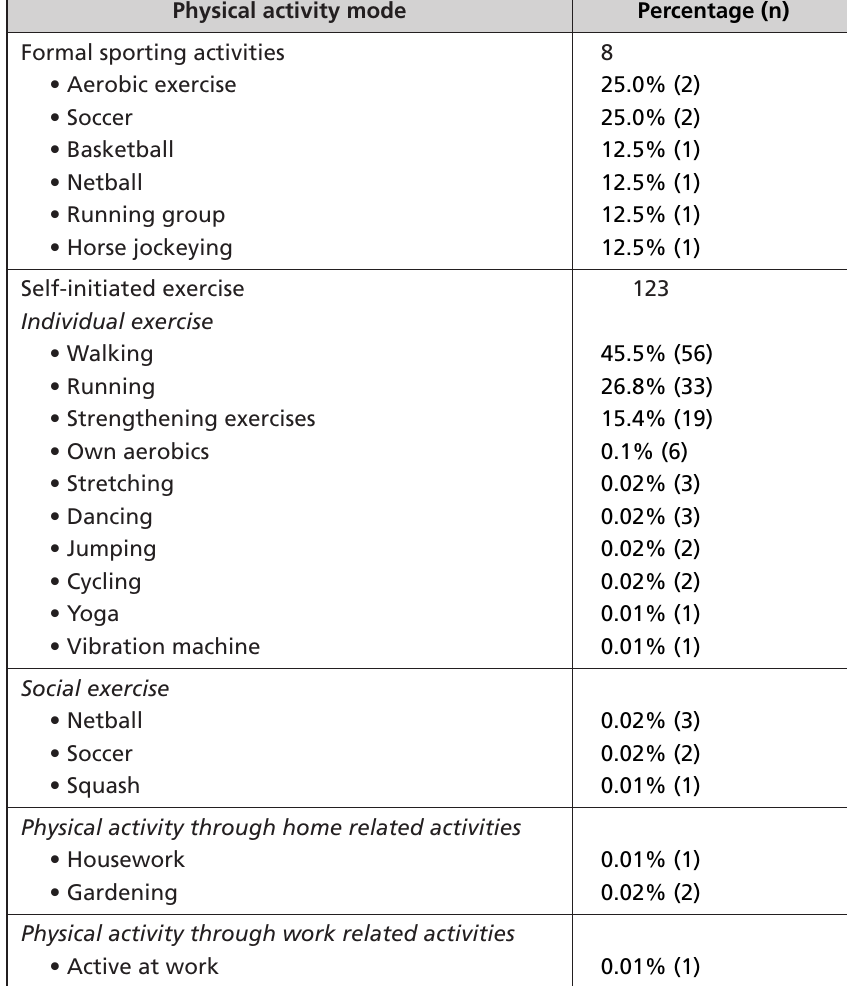
Table 2: Physical activity preferences of exercising study participants Physical activity